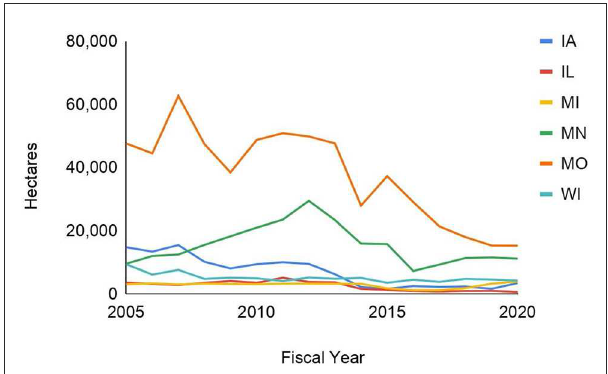
FIGURE4 Area receiving prescribed grazing as a conservation practice through USDA-NRCS agreements. Data Source: USDA Natural Resources Conservation Service (2020a,b,c,d,e,f), National Planning and Agreements Database, practice code 528 (2020).